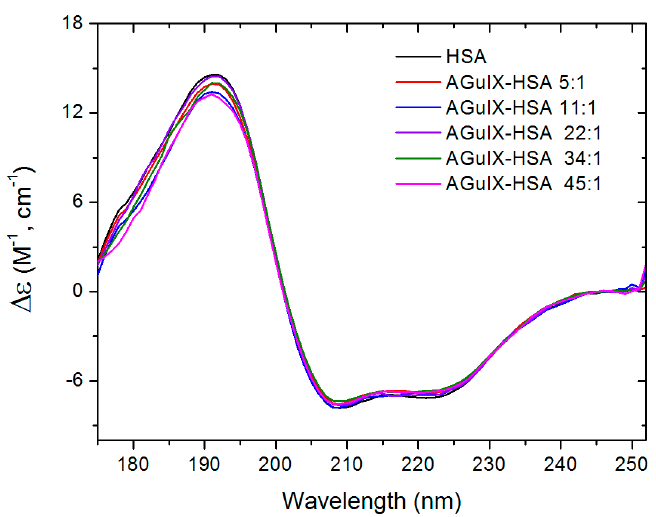
Figure 2. SRCD (synchrotron radiation circular dichroism) spectra of pure HSA 3100 µ g / mL (black) and HSA in the presence of AGuIX ® at di ff erent AGuIX ® :HSA ratios 5:1(red), 11:1 (blue), 22:1 (purple), 34:1 (green) and 45:1 (pink) in 10 mM phosphate bu ff er at pH 7.4 and 37 ◦